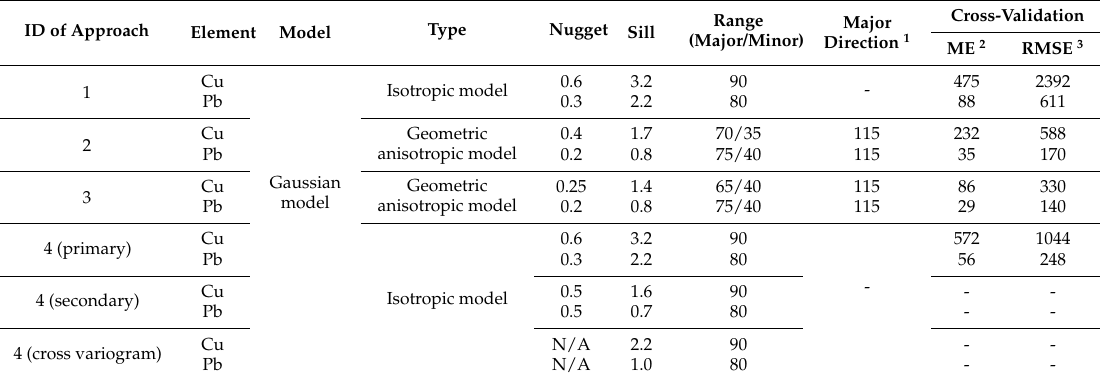
Table 3. Variogram modeling parameters used for the generation of soil contamination maps and results of cross-validation test.